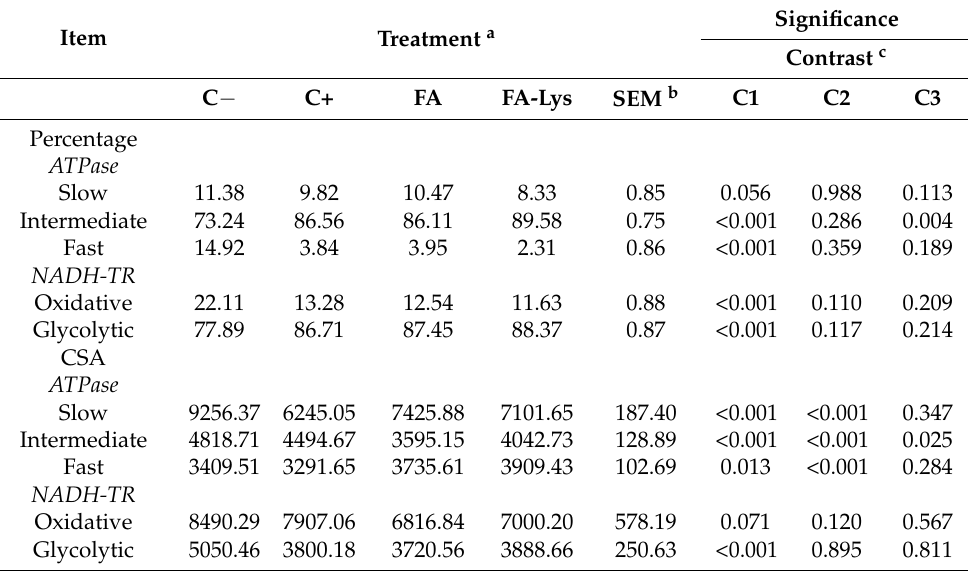
Table 3. Percentage of fibers and cross-sectional area (CSA, µ m 2 ) for each skeletal muscle fiber types in finishing pigs supplemented with FA or